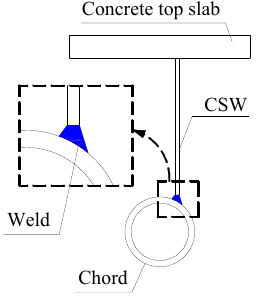
Figure 16. Fatigue details.